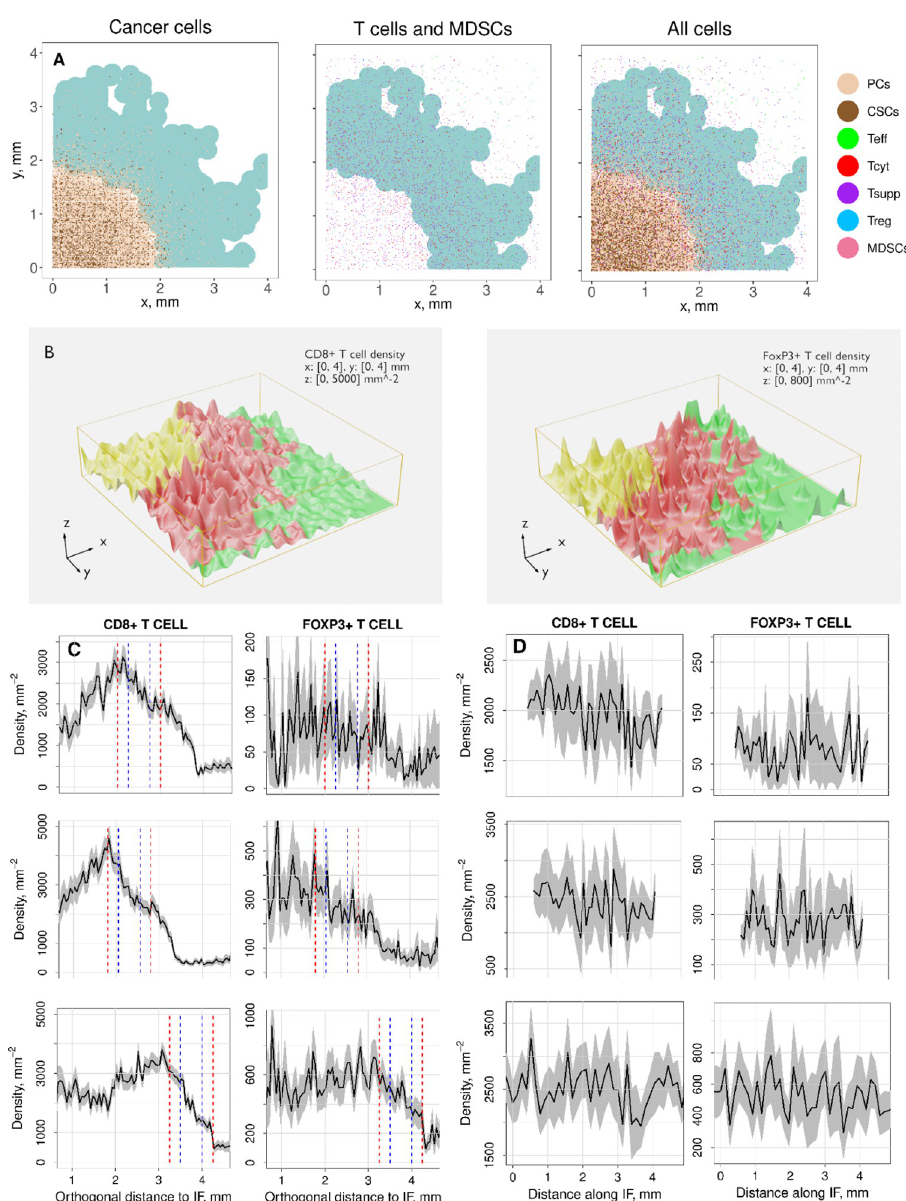
Fig 8. Cell distribution and cell density at the IF under treatment. Panel A: Spatial representation of cancer cell subtypes (left), CD8+ T cells subtypes, FoxP3+ T cells, and MDSCs (center), and all cells (right) in a section of a tumor slice. The IF region is depicted in pale turquoise. Slow tumor growth case ( k C1,growth = 0.005 day -1 ) and R << 1 (R = 1/ 50). Panel B: 3D representation of CD8+ T cell and FoxP3+ T cell densities in the central tumor (CT; yellow), the invasive front (IF; red), and the normal tissue (N; green). Panel C: Average of CD8+ T cell and FoxP3+ T cell density profiles that are perpendicular to the IF. 95% confidence intervals are calculated upon the profile (grey areas). Two definitions of IF are introduced here and are indicated as vertical lines, blue: width w pathol =0.5 mm; red: width w pathol =1 mm. Panel D: Average of CD8+ T cell and FoxP3+ T cell density profiles along the IF. In panels C and D every row is a case with a different combination of ratios k C1,growth /k C,T1 , k T1 /k Treg , and the parameter T reg,max , where k C1,growth , k C,T1 , k T1 , k Treg , and T reg,max are the cancer cell growth rate, the rate of cancer cell death by T cells, the exhaustion rate of cytotoxic T cells by all cells that express PD-L1, the inhibition rate of cytotoxic T cells by regulatory T cells, and the maximal regulatory T cell density in the tumor, respectively. The spatial QSP algorithm calculated the evolution of a tumor slice starting from a fraction of a normal distribution of cancer cells. QSP model and ABM are coupled before reaching the point where T cells are recruited and also before the initial tumor diameter condition from the QSP model is met. Thus, no initial T cell spatial distribution is enforced. The figures here presented show cell distributions and densities 6 months after the initial tumor diameter condition is met with 3 mg/kg nivolumab administered every two